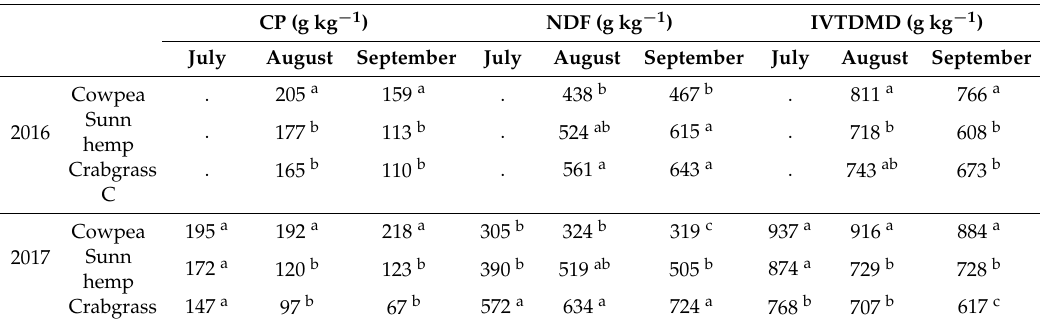
Table 2. Nutritive value (crude protein, CP; neutral detergent fiber, NDF and in vitro true dry matter digestibility, IVTDMD) of the forage crops intercropped with corn during the growing season in 2016 and